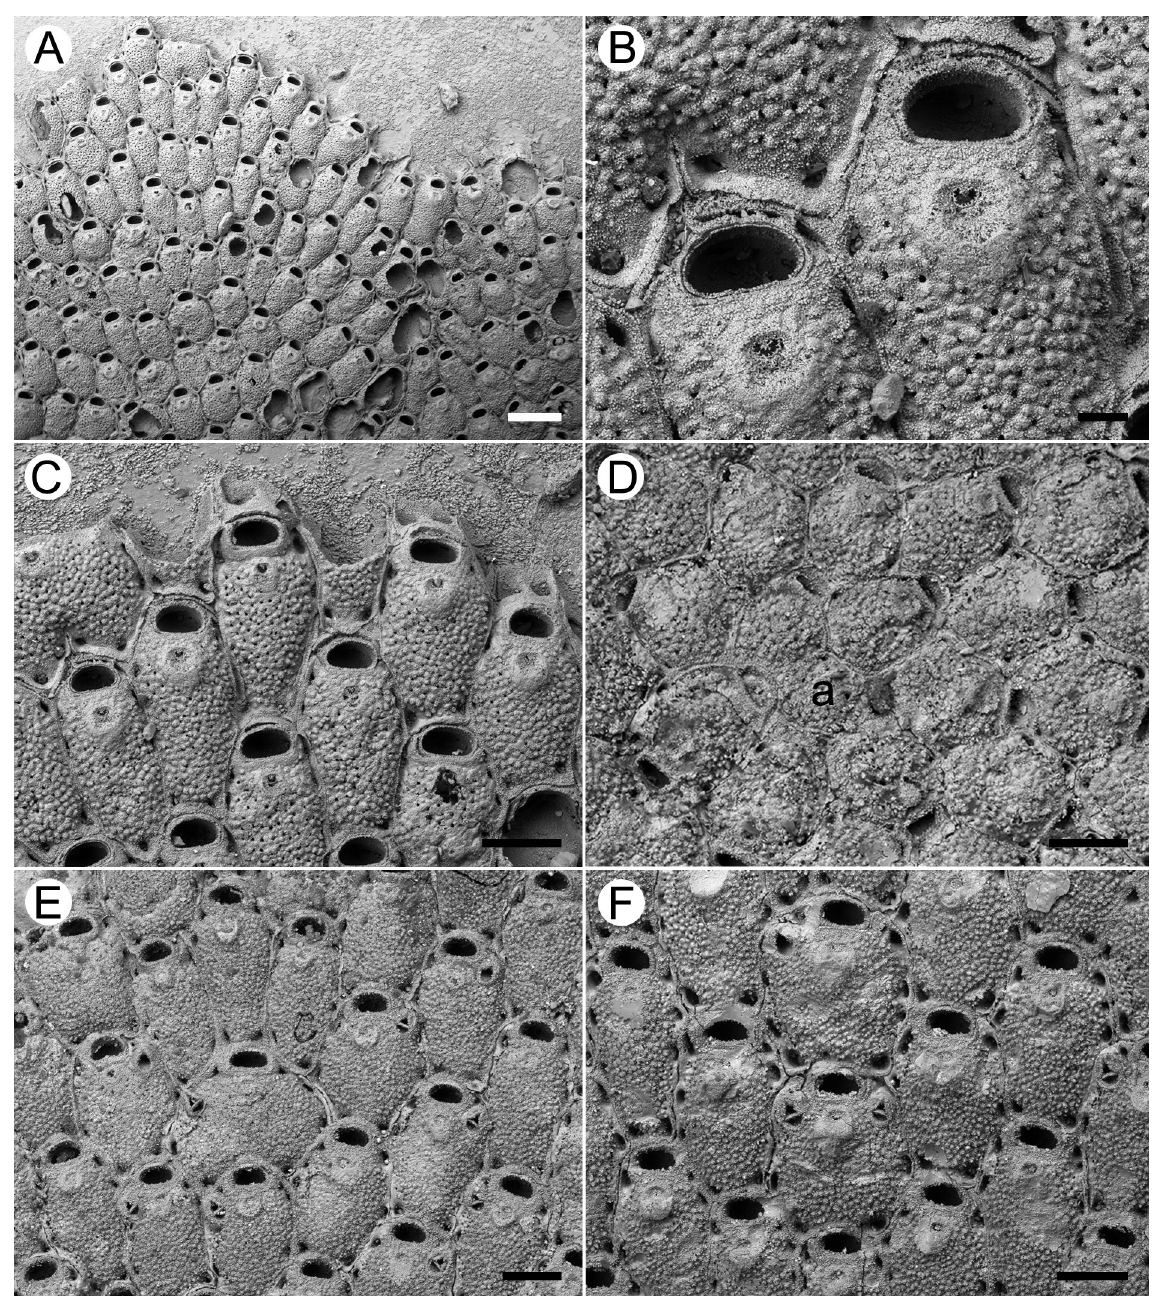
Fig. 4. Microporella rusti sp. nov. A–C . Holotype (GNS BZ 336), Nukumaruan, Pleistocene, Nukumaru Limestone, Waiinu Beach, New Zealand. A . View of two colonies growing side by side. B . Close-up of two autozooids lacking avicularia, showing the orifice and ascopore. C . Close-up of zooids at the growing edge. D . Paratype (NHMUK PI BZ 7834), same provenance as holotype, showing ancestrula (a) and early astogeny. E–F . Paratype (NHMUK PI BZ 7835), same provenance as holotype. E . Group of zooids. Note the large zooid at the centre preceding row division. F . Group of zooids. Note the zooid at the centre bearing two avicularia. Scale bars: A = 500 µm; B = 50 µm; C–F =